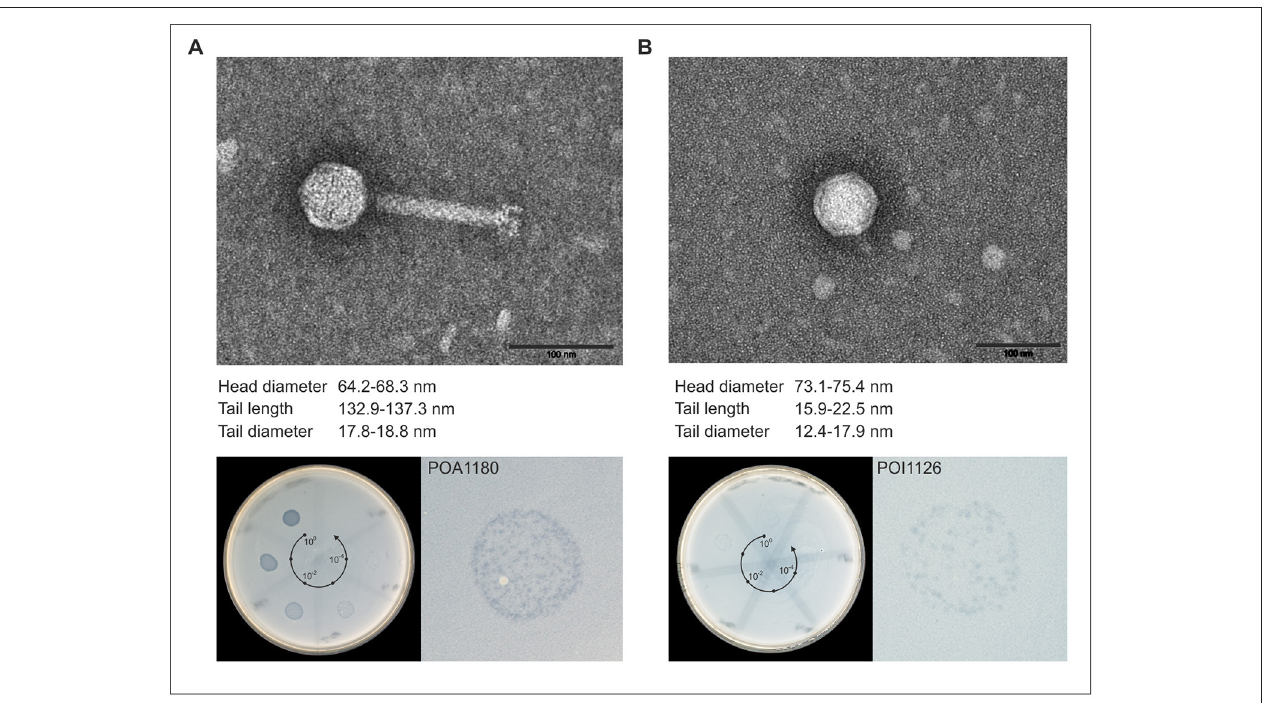
FIGURE 2 | Morphology and lytic activity of POA1180 and POI1126. In the upper part, transmission electron micrographs (TEM) of POA1180 (A) and POI1126 (B) phage particles isolated from Ochrobactrum strains O1180 and O1126, respectively, by mitomycin C induction are shown. The black bar represents a size standard of 100 nm. The lower part demonstrates the lytic activity of the phages POA1180 (A) and POI1126 (B) . The left panels show the lytic activity of the indicated phages during spot testing. On the bacterial lawn of O. anthropi strain O1129, 10 µ l of a 1:10 dilution series (spot 1–6) of the P1180 and P1126 phage lysates was applied. The right panels show a six-fold magnification of a representative spotting zone comprising single